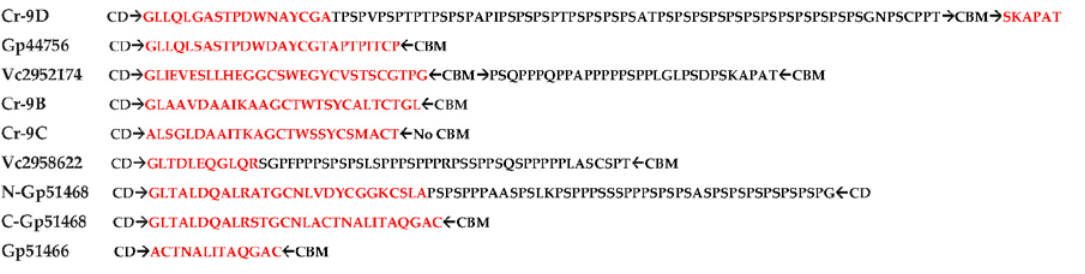
Figure 7. Linkers in microalgal cellulases (between the arrows). Black, PS, or PST linkers; red, putative linker sequence (or may be part of C-terminal CD or N-terminal CBM).